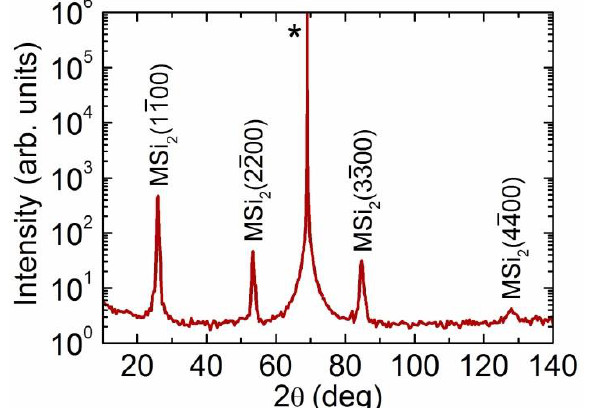
Fig. 2.  -2  XRD scan for the SiO x /EuSi 2 /SrSi 2 /Si(001) film. Peaks from SrSi2 and EuSi2 are not resolved, a peak from Si is marked